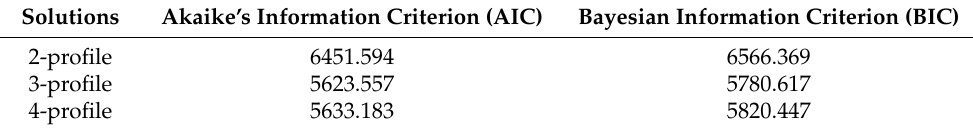
Table 2. Fit statistics of various solutions from latent profile analysis (LPA) 1